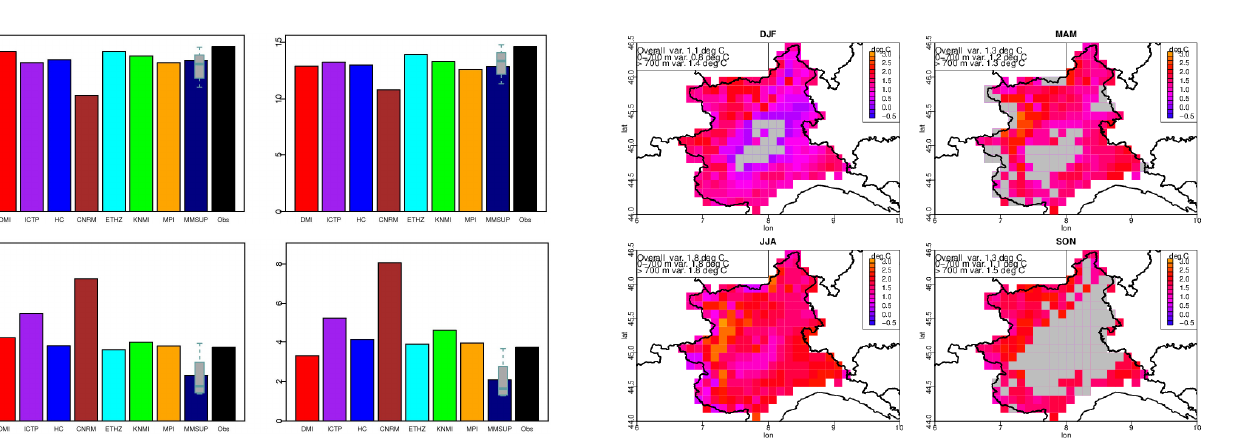
Fig. 8 : (top) number of dry periods (5 consecutive days with precipitation < 1 mm) /year for reanalysis (left) and scenario (right); (bottom) number of wet periods (5 consecutive days with precipitation > 1 mm) /year for reanalysis (left) and scenario (right); input models (colours), Multimodel (blue) and observations (black), period 1981-2000. Precipitation is calculated as the average over the Piedmont gridpoints. Multimodel uncertainty is represented as boxplots of the dry/wet mean number of days in the MonteCarlo experiment (5 th , 25 th , 50 th , 75 th , 95 th percentiles are shown).